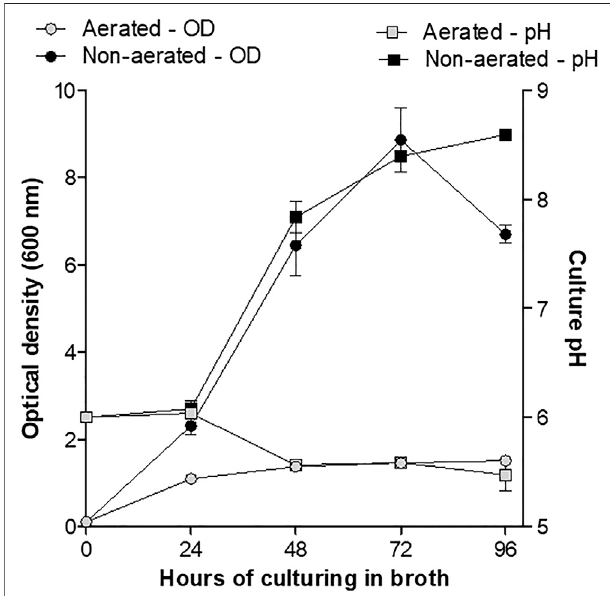
FIGURE 1 | Changes in growth (optical density) and culture pH of X. khoisanae J194 under non-aerated (method A) and aerated (method B) culturinginbrothover4 days.Datadepictsthemeanofthethreeindependent cultures. Error bars show standard deviation.